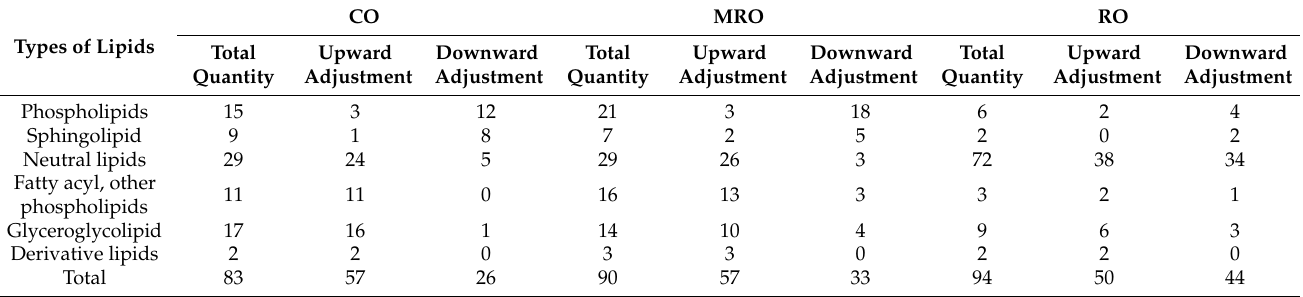
Table 5. Statistical table of differential lipids in three kinds of camellia oils after